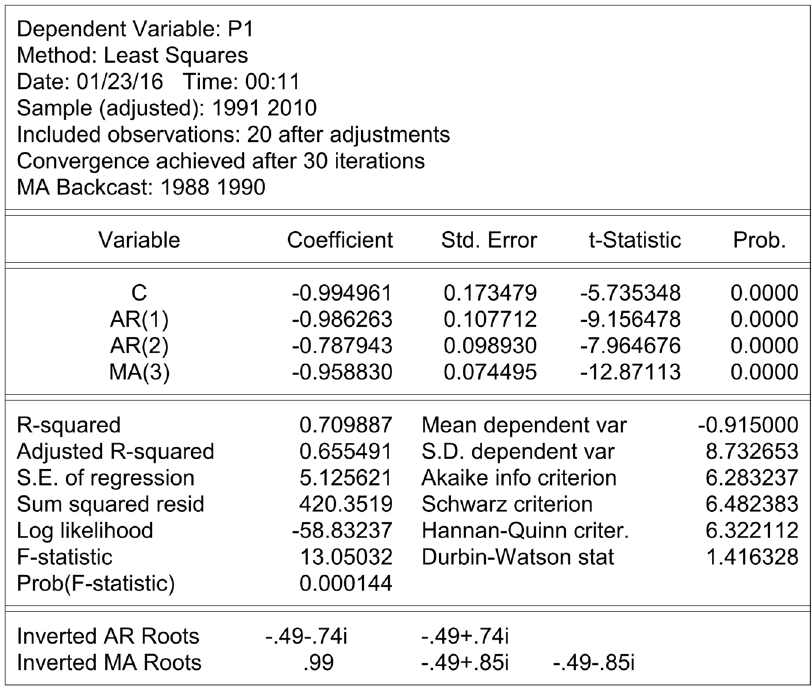
Figure 5. The result of AMIRA (2,1,3) model.